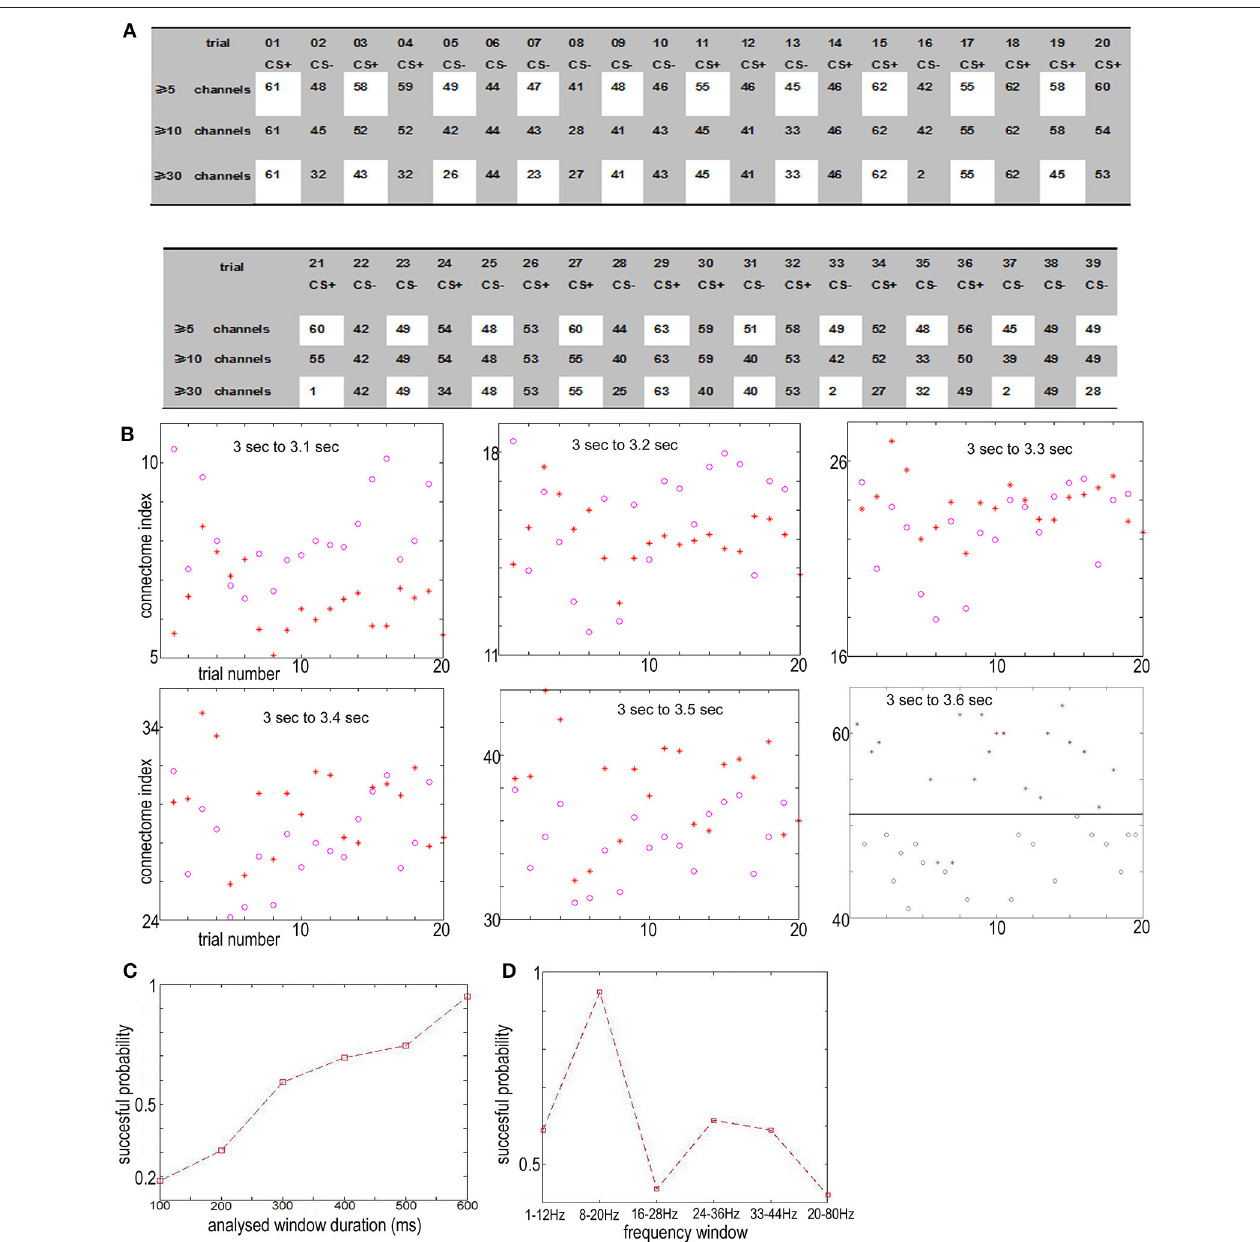
FIGURE 4 | (A) The connectome index in the 8–20Hz band from 3 to 3.6s (just after CS onset) ranged from trail 01 to trial 39. The three rows show the results of connectome across more than 5, 10, and 30 channels. The connectome index for CS connectome across more than 5 channels). (B) Varying the analysis window duration from 100 to 600ms yielded a window length of 600ms as optimal for pattern classification by the connectome across more than 5 channels. CS pattern classification for the connectome across more than 5 channels. (D) Successful probability vs. frequency